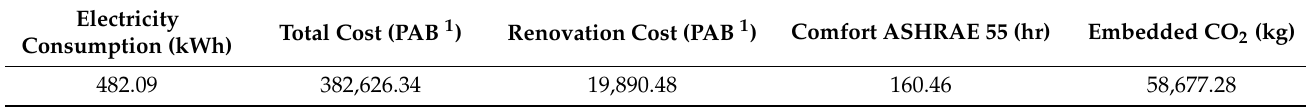
Table 9. Optimization analysis results obtained with the design variables selected. Table 7. Electricity consumption and cost of electricity consumption of the optimized urbanization in a year.